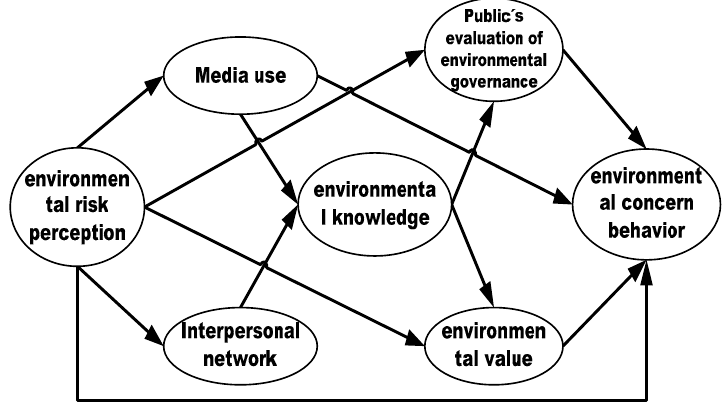
Figure 4. Risk perception enhancement path: from environmental risk perception to environmental concern behavior.